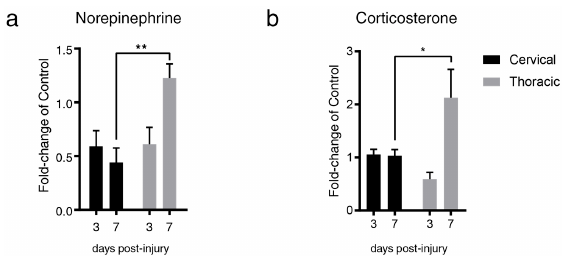
Figure 1. Experimental design. Two moderate-severe spinal cord injury (SCIs) were induced at cervical (C6–7) and thoracic (T6–7) levels and splenic cortisol (CORT), norepinephrine (NE), and inflammatory profile were assessed 3- and 7-days post-SCI.